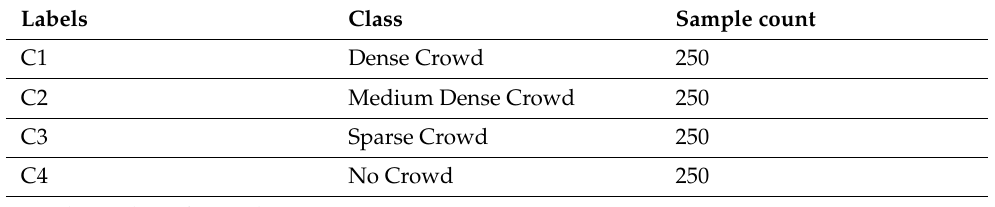
Table 1. Dataset details.